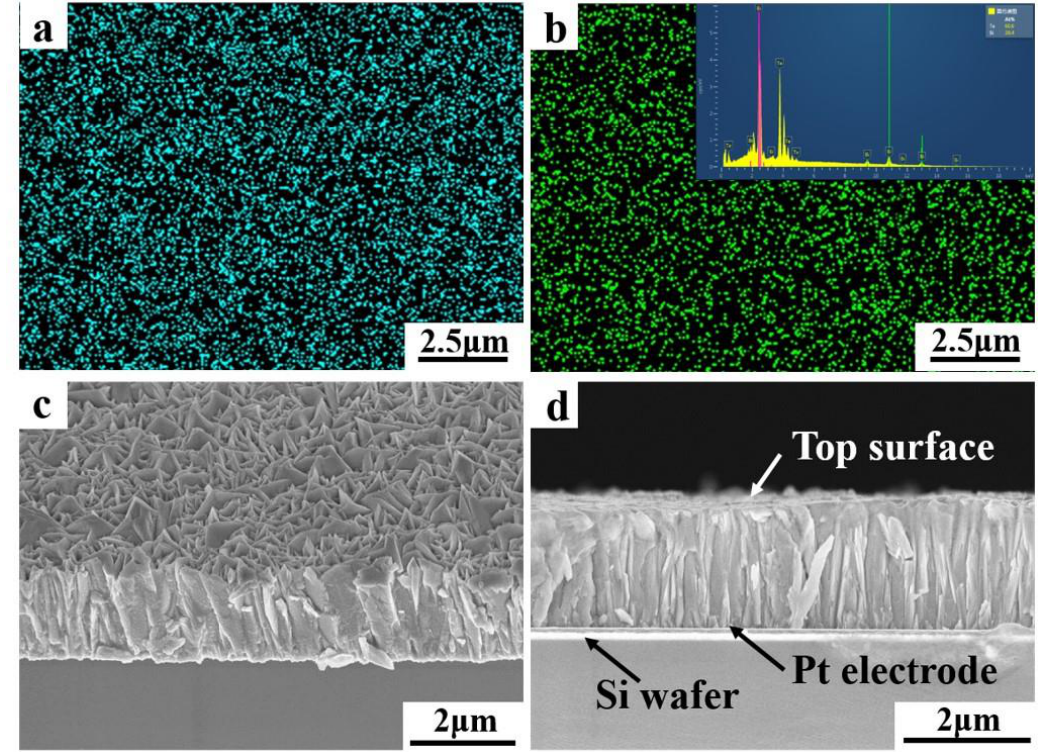
Figure 6. ( a , b ) Bi and Te distributions in the thin films deposited at − 35 mV in the electrolyte containing 7.5 mM Bi and 10 mM Te. ( c , d ) Micro-topographies of the oblique and lengthwise sections of the film.